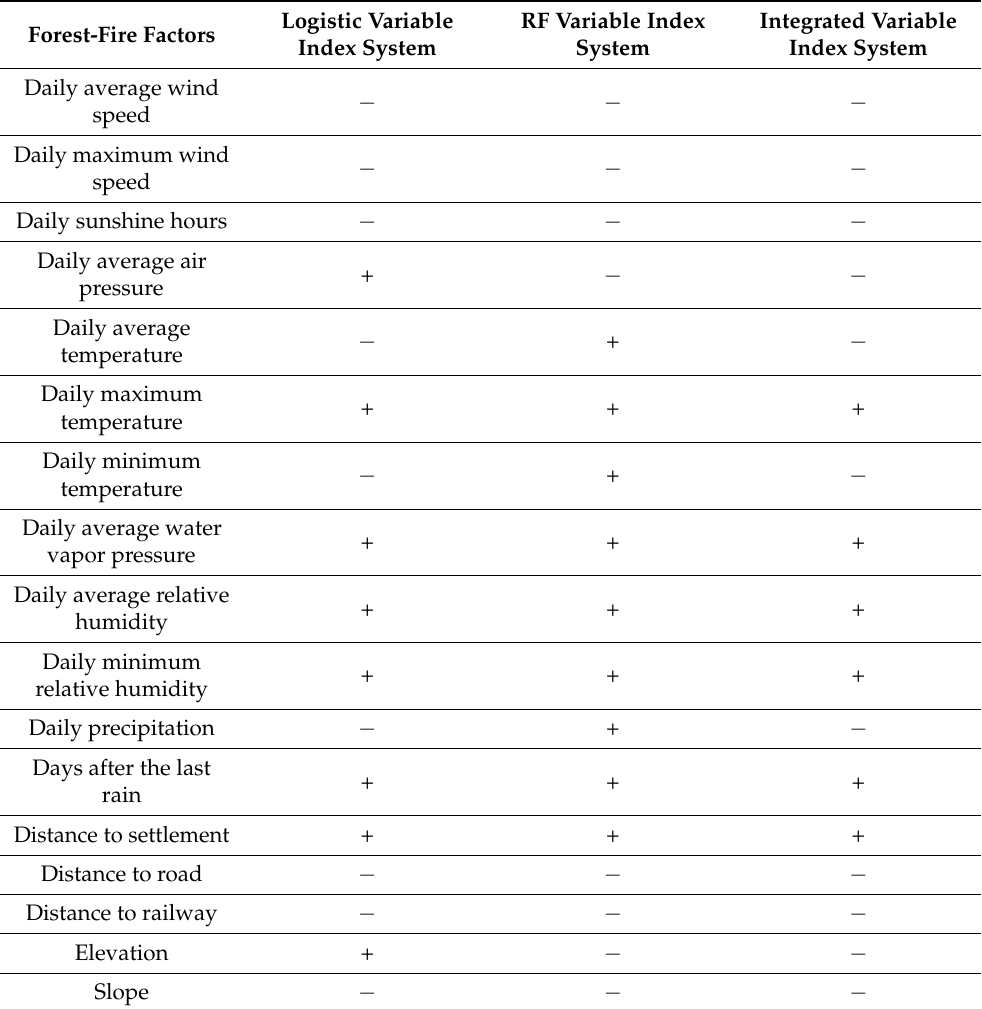
Table 2. Three variable index